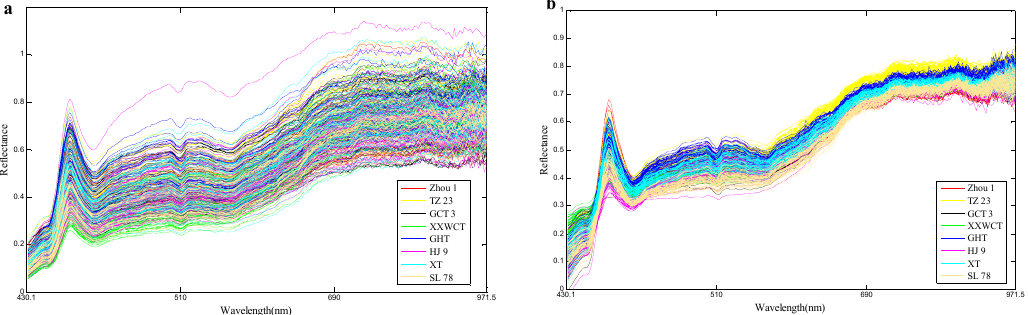
Figure 7. ( a ) Raw spectra of eight maize varieties in the train set, and ( b ) PA-preprocessed data for the raw spectra.